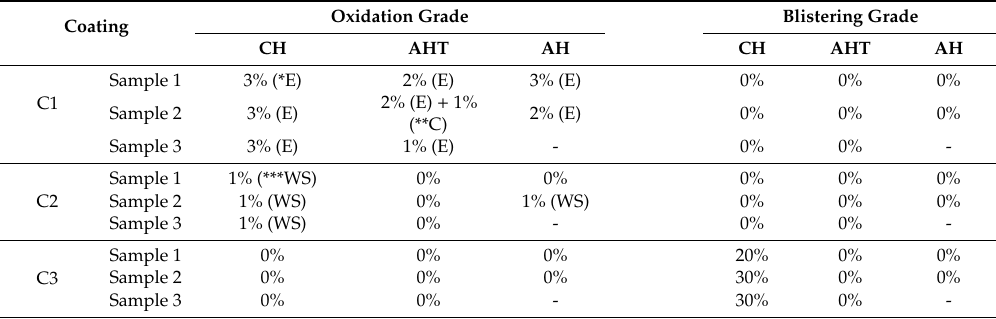
Figure 7. Visual appearance of the coatings’ surfaces at different evaluations during the condensation tests with alternating temperature (AT) according to the ISO 6270-2 standard. Table 5. Summary of the oxidation and blistering grade of the coatings after the condensation tests in accordance with the ISO 6270-2 standard [24] regarding the percentage of damaged